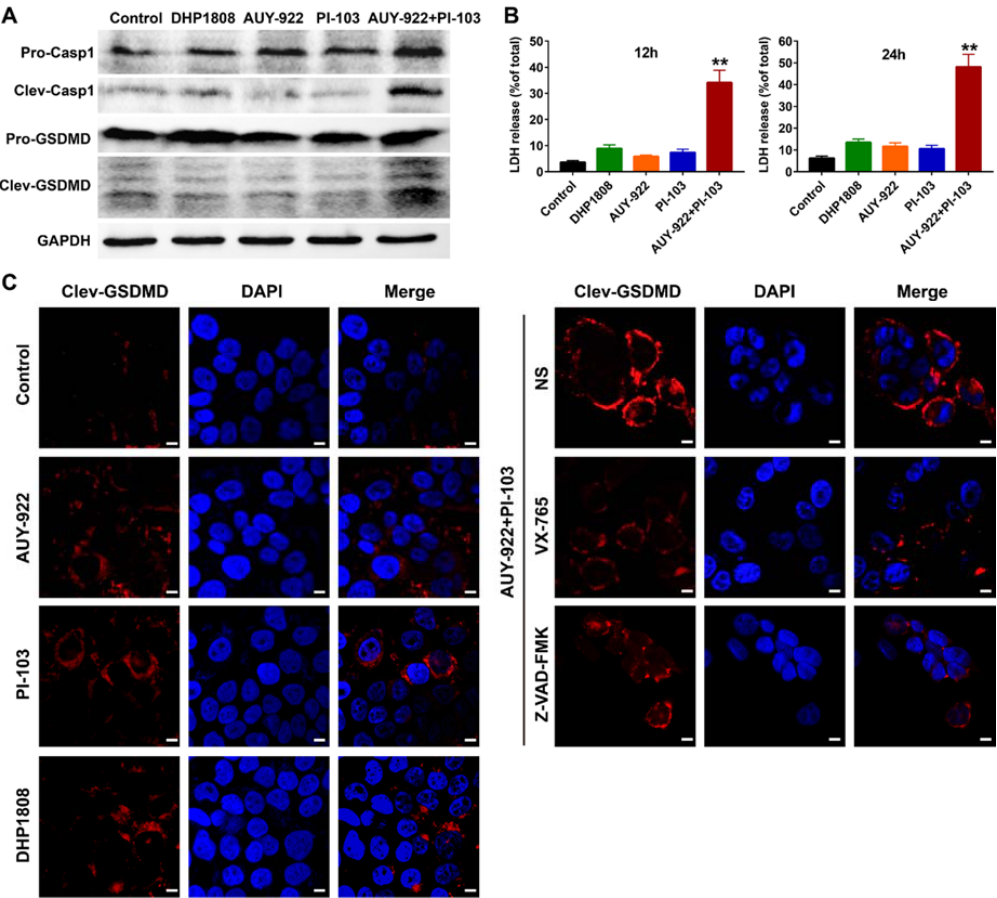
Figure 6. DHP1808 induced less pyroptosis than the combination of HSP90 and PI3K inhibitors. ( A ) WB analysis of the whole protein and cleaved forms of caspase ‐ 1 and GSDMD in A375 melanoma cells. ( B ) The release of LDH in A375 cells after 12 h or 24 h of drugs incubation, ** p < 0.01 versus the control group. ( C ) The immunofluorescent assay of cleaved GSDMD in A375 cells. The